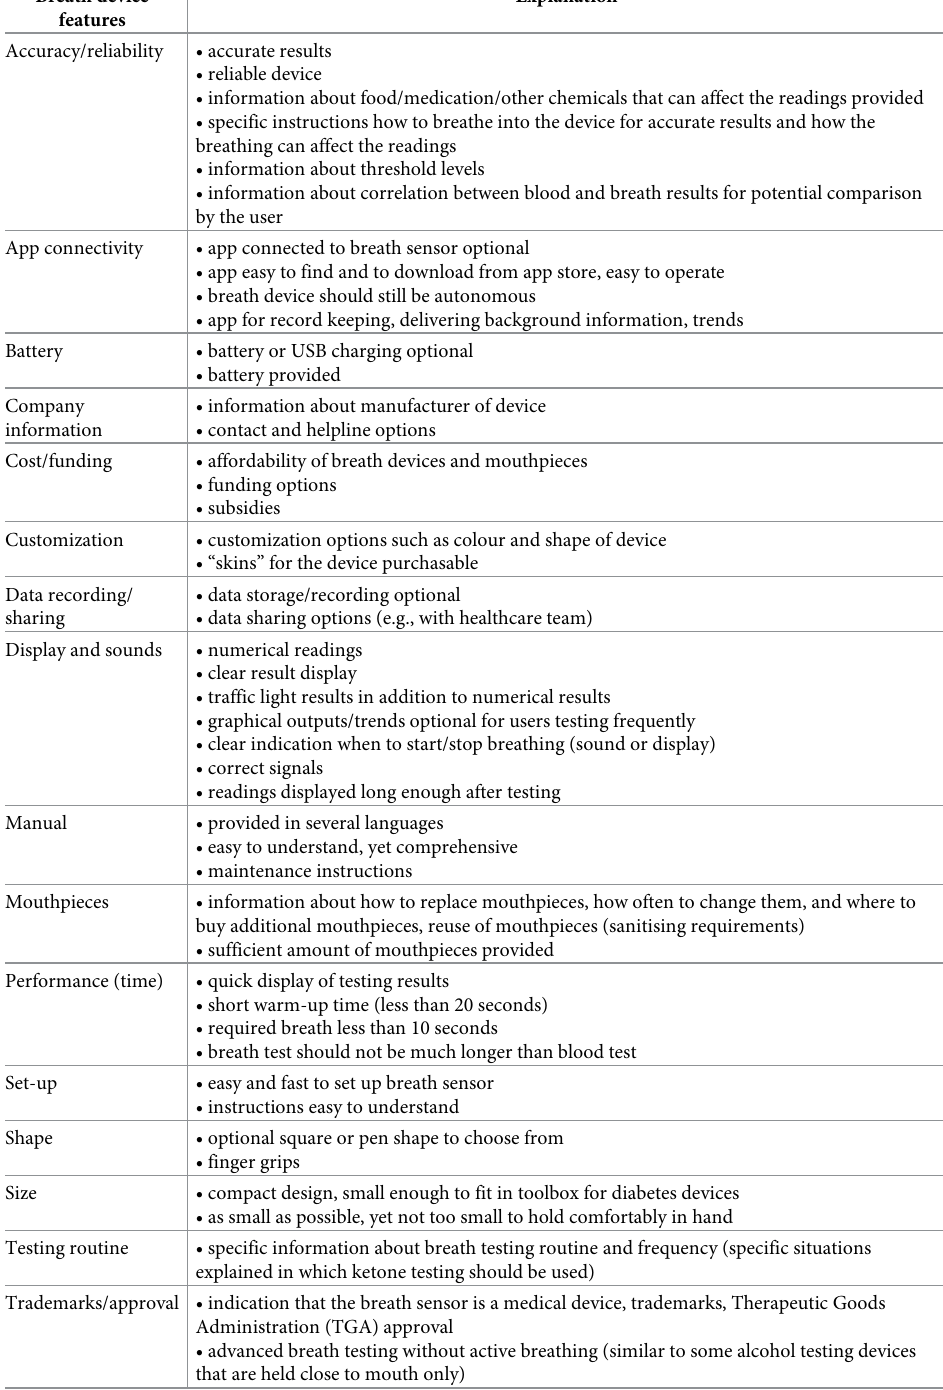
Table 5. Summary of preferred breath ketone sensor